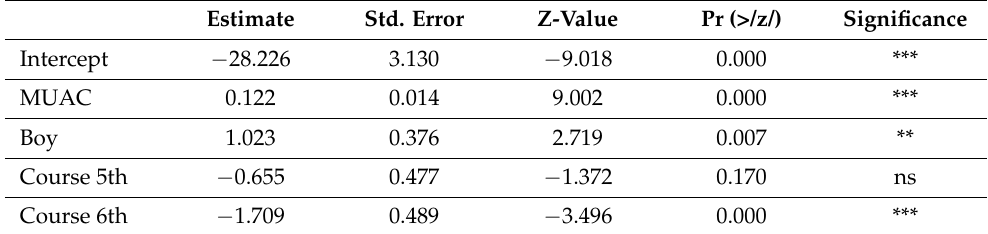
Table 3. Generalised linear model summary for overweight. Estimate Std.